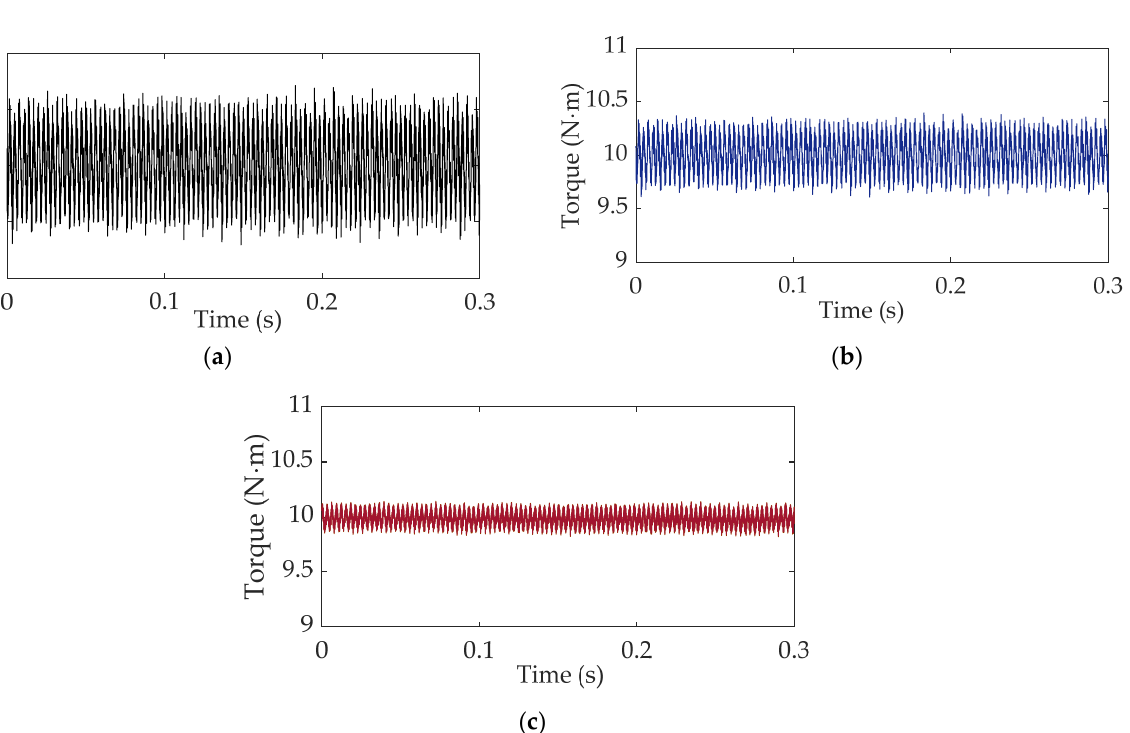
( b ) ( c ) Figure 10. Flux linkage at a steady-state speed of 1500 r·min − 1 with a 10 N·m load for the ( a ) TDTC, ( b ) CMPTC, and ( c ) proposed MPTC methods.